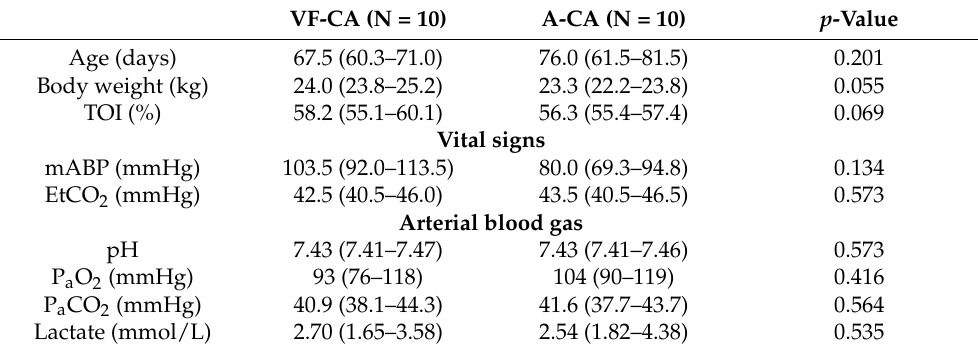
Table 1. Baseline characteristics of the